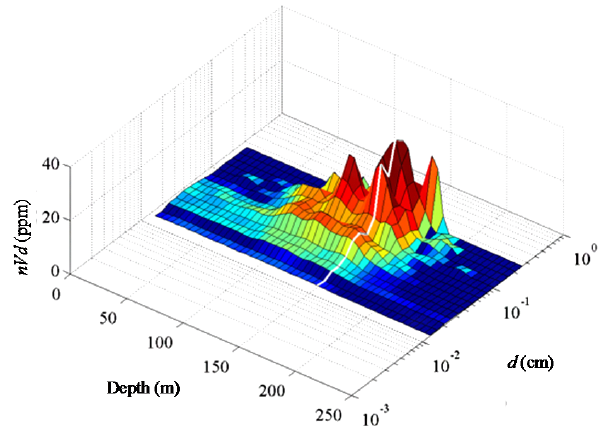
Figure 6. Volume distribution size spectra along vertical axis on the 17 of November at 01:10LT (A3-2/5). The white line indicates values at 150m, the bottom of the model